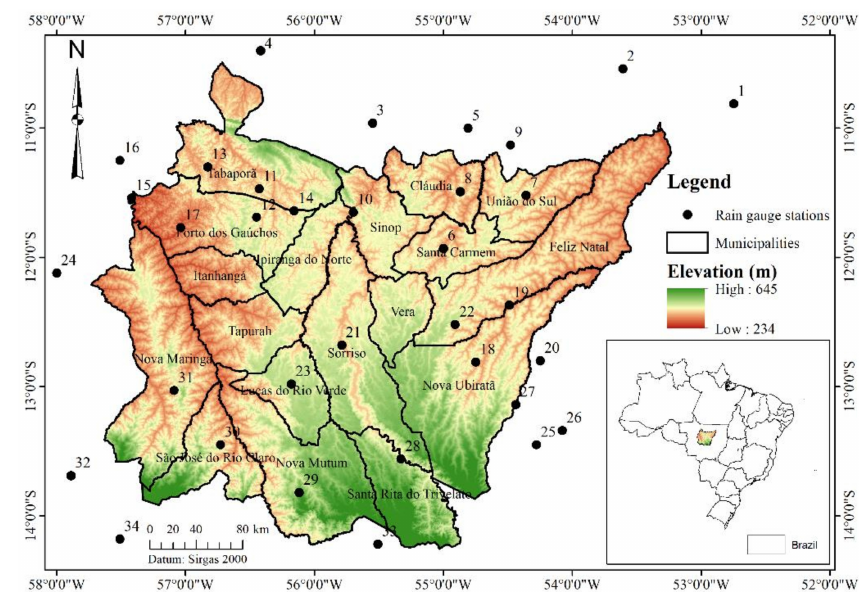
Figure 1. Map of the study area, location of the rain gauge stations belonging to the hydrometeorological network of the National Water Agency, and municipalities included in the north–central region of the State of Mato Grosso,